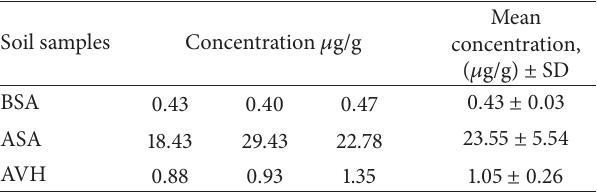
Table 5: Selenium concentration of soil samples. Soil samples